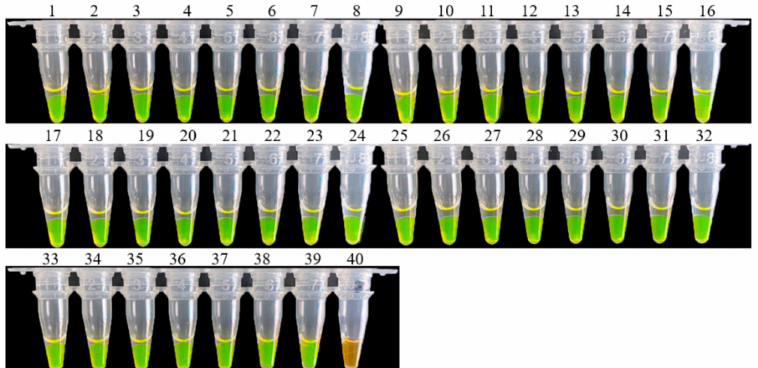
Figure 9. Profiles of loop-mediated isothermal amplification (LAMP) for 39 P. graminea isolates. Assessments of LAMP products based on SYBR Green I visualization of color change. Tubes 1 to 39, P. graminea isolates Pg-1 to Pg-39 isolated from 39 different barley-growing areas in Qinghai, China; tube 40, DNA-free ddH 2